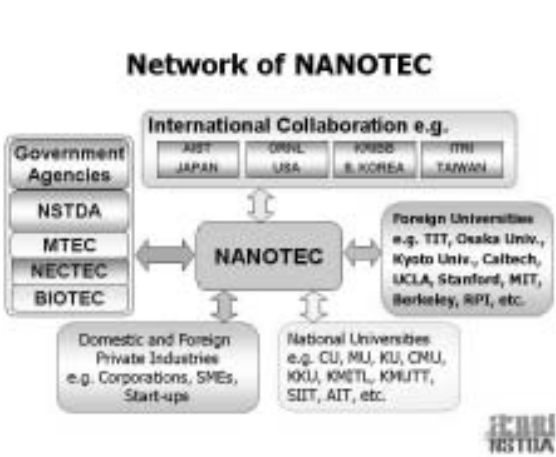
Fig. 4 Schematic of national and international alliances of NANOTEC